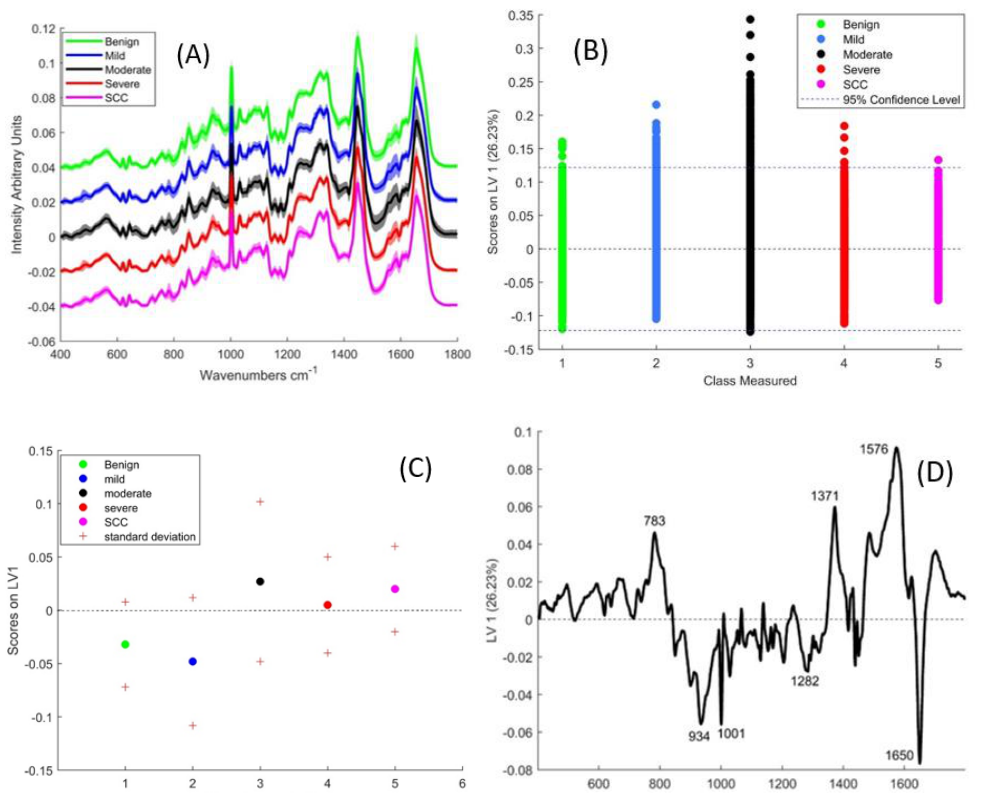
Figure 1. ( A ) Mean Raman spectra of benign, mild, moderate and severely dysplastic epithelial tissue. The spectra have been offset for clarity and shading denotes standard deviation ( B ) A plot of the PLSDA scores according to LV-1 ( C ) Mean and standard deviation of PLSDA scores of LV-1 ( D ) LV-1 of the PLSDA model for Epithelial tissue, including all the classes. Table 1. Tentative peak assignments, adapted from Movasaghi et al. [30].